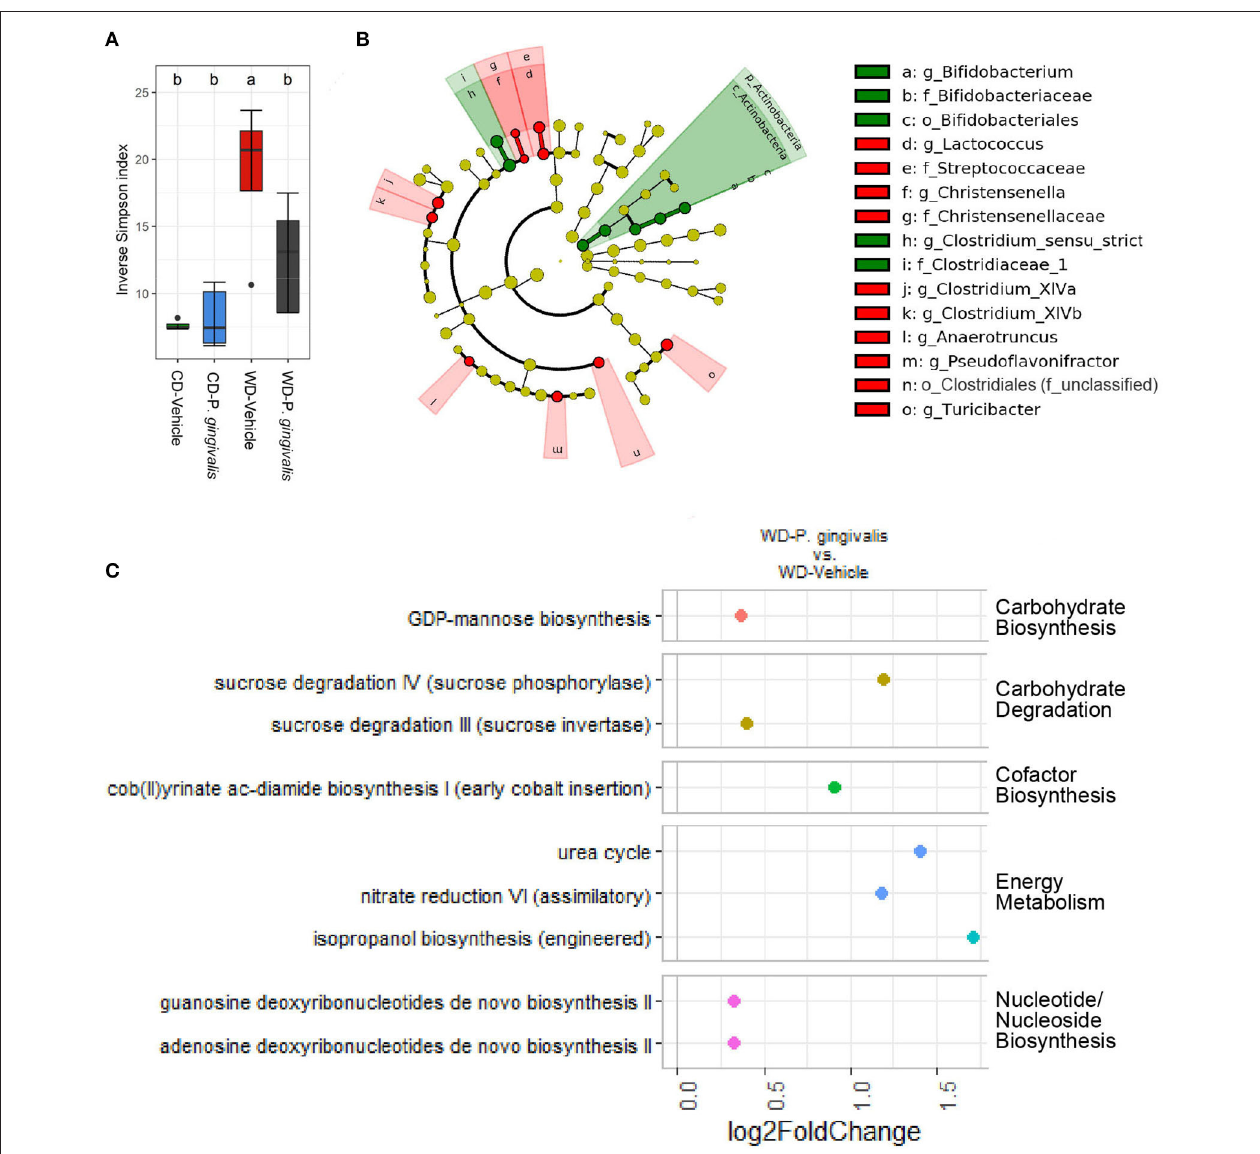
FIGURE 8 | Acute P. gingivalis infection induces dysbiosis in mice fed a Western diet. Results of 16S rRNA gene sequencing of the fecal microbiota collected 1 day after the final P. gingivalis infection. (A) Inverse Simpson index measuring alpha diversity. Groups with different letters (a, b) are significantly different. (B) Linear discriminant analysis (LDA) effect size (LEfSe) analysis of the predicted taxonomy of P. gingivalis vs. vehicle-treated mice fed a WD during acute infection. LDA > 2.0, α < 0.05. Green indicates increased abundance while red indicates reduced abundance in response to P. gingivalis. (C) Predicted pathways expected to be differentially abundant when comparing the inferred cecal metagenome enrichment of P. gingivalis -infected, WD-fed mice and vehicle-treated, WD-fed mice. No significant differences were observed between P. gingivalis -infected, CD-fed mice and vehicle-treated, CD-fed mice. Significance assessed by DESeq2 with an adjusted p -value <